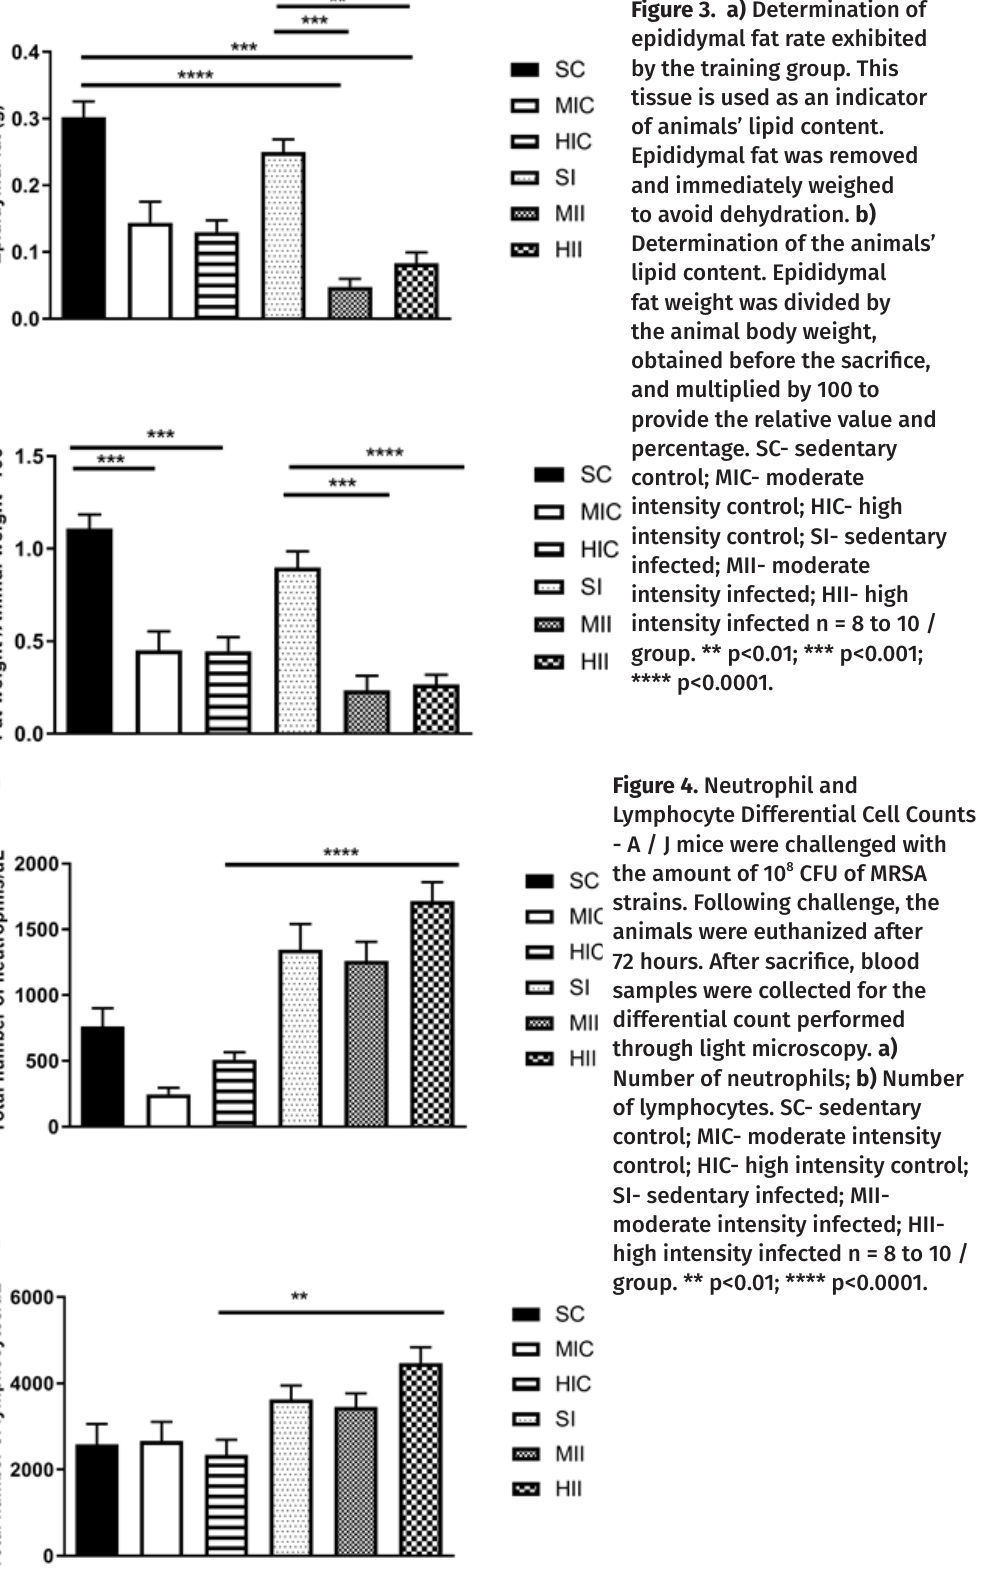
Figure 3. a) Determination of